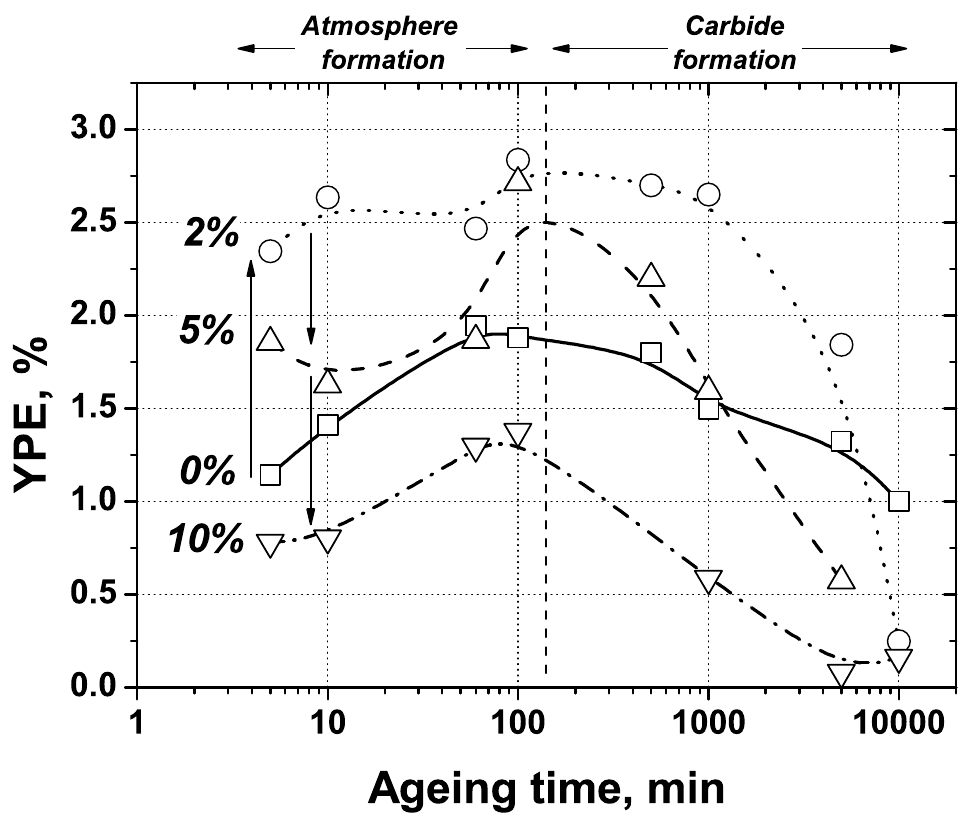
Figure 6. Yield point elongation as function of the aging time for aging at 170 ◦ C from 5 to 10,000 min for 0%, 2%, 5%, and 5% prestrain for the temper rolled TRIP5